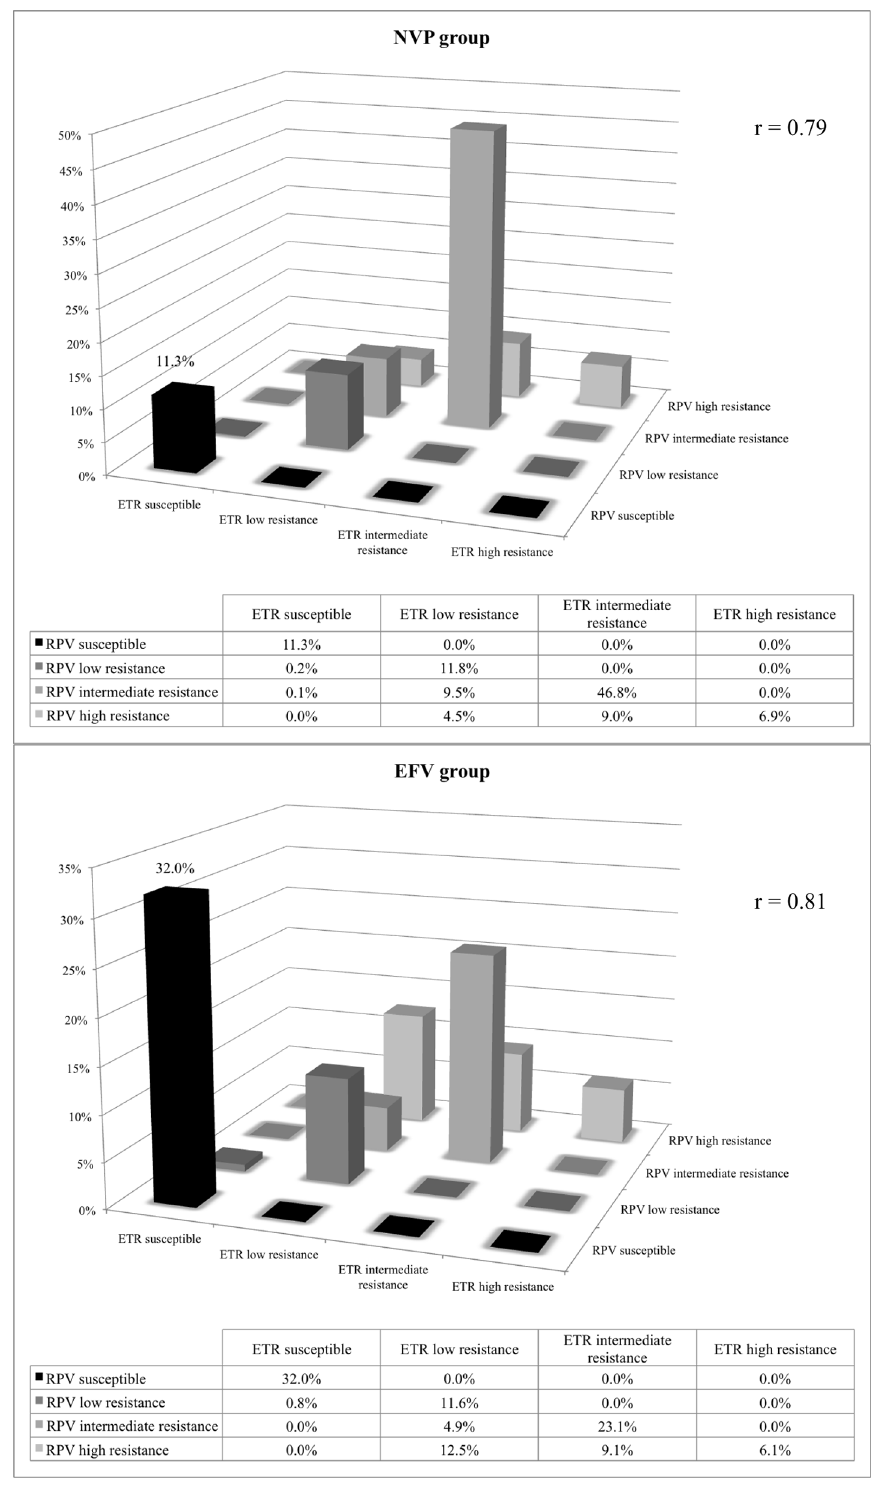
Fig 2. Susceptibility pattern of etravirine and rilpivirine in patients who failed nevirapine and efavirenz-based regimens. doi:10.1371/journal.pone.0154221.g002 PLOS ONE | DOI:10.1371/journal.pone.0154221 April 27,